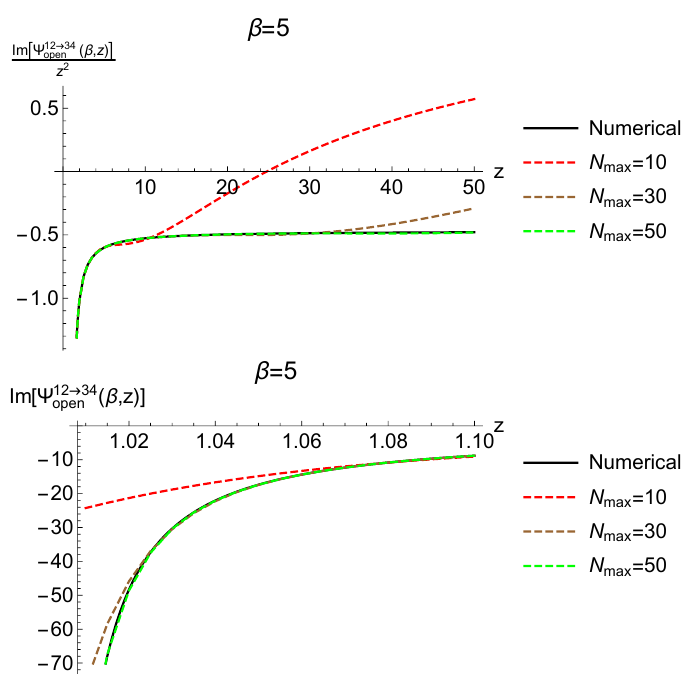
Figure 3: Here we present the comparison of numerical evaluation of Mellin inte- gral and residue sum formula eq.(79) for the imaginary part of celestial open string ( β , z ) in z → ∞ and amplitude. LHS and RHS shows the behavior of Im Ψ 12 ↔ 24 open z → 1 ( β , z ) = 0 because the open string amplitude T ( s , t ) has no u - Note that Im Ψ 13 ↔ 24 open open channel pole. The comparison of the truncated sum of eq.(79) with the result from the ( β , z ) numerical Mellin integral (28) is given in Figure 3. One can see that Im Ψ 12 ↔ 34 open diverges in the limits z → ∞ and z → 1. The divergent at z → ∞ is due to the overall prefactor B 12 → 34 ( z ) = π z 2 , while the divergent at z → 1 is due to the non-convergence of the residue sum reflecting the massless 1 / t singularity in that limit. Note that the divergence occurs for positive β . For negative β the imaginary part is finite as we will see in Section